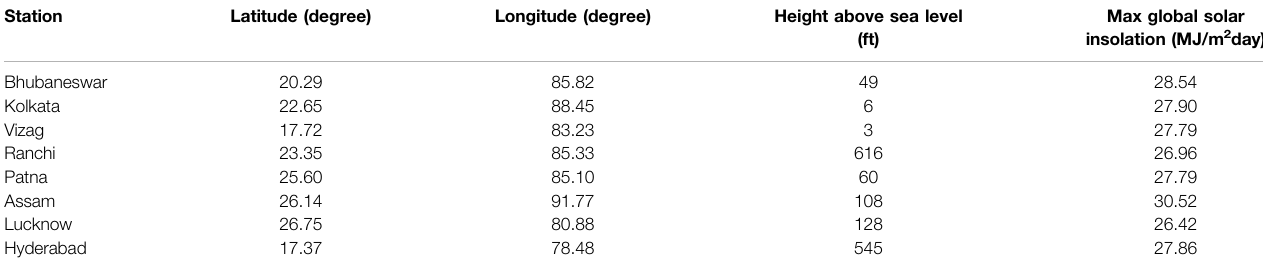
TABLE 1 | Geographical and meteorological data related to places of Eastern India.